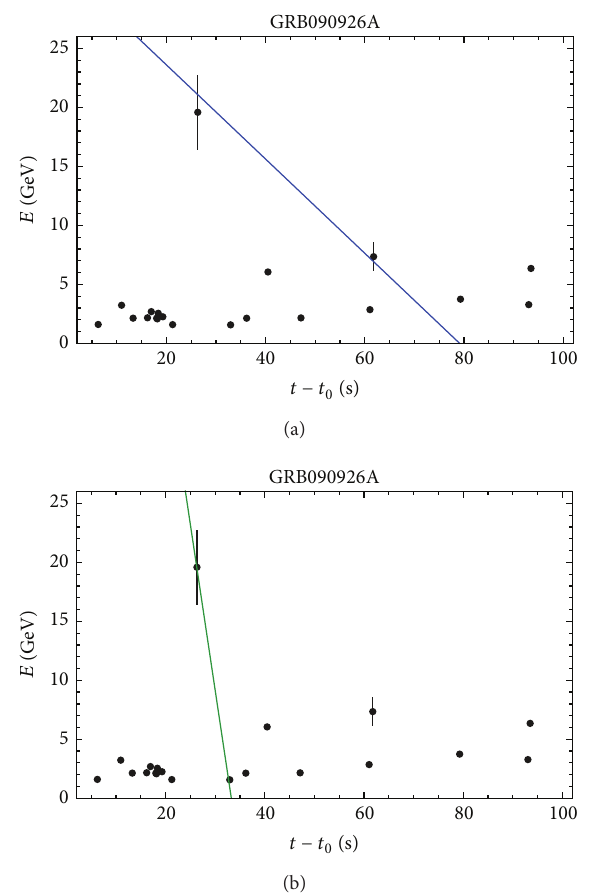
Figure 12: Here shown is the Fermi-LAT sequence of photons with energy greater than 1.5 GeV for GRB090926A. We visualize an error bar at the 15 % level for the energy of the two most energetic events. (b) A straight line with the slope we derived in Section 3. (a) A straight line with slope obtained from the slope derived in Section 3 by rigidly rescaling it by the factor of 𝐷(0.34)/𝐷(2.106) (2.106 being the redshift of GRB090926A) dictated by our